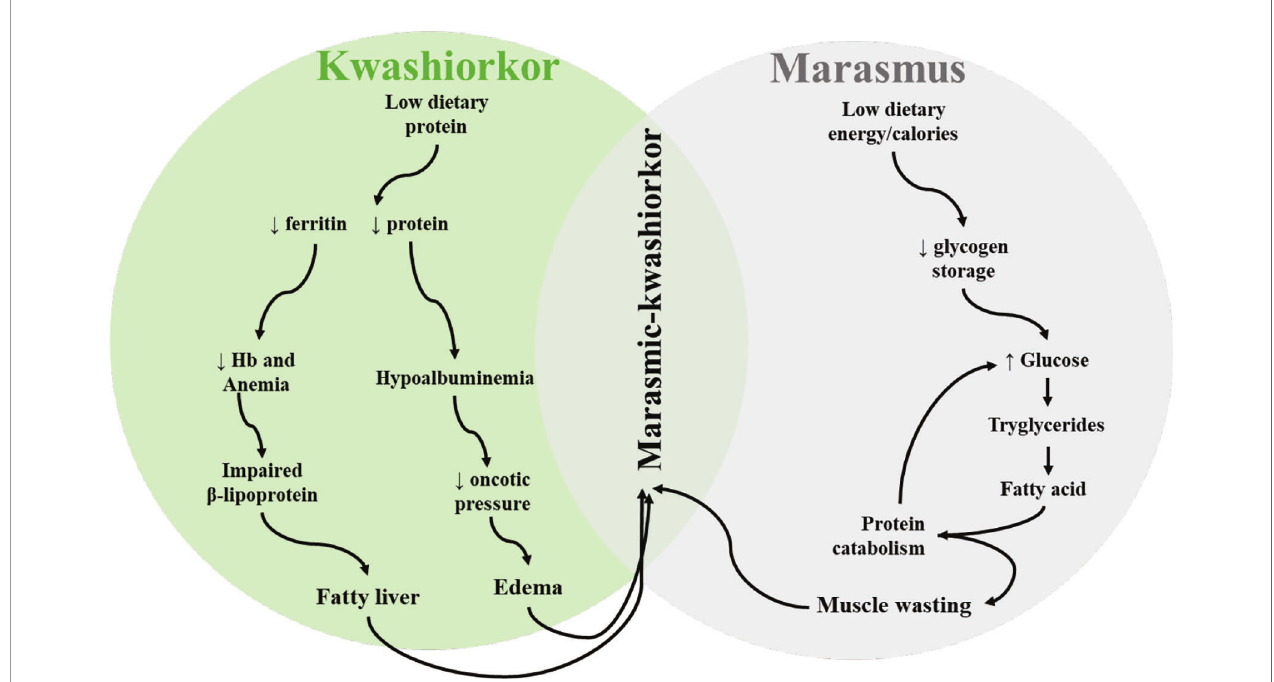
FIGURE 2 | Schematic depiction of pathobiological features and interactions observed in different types of malnutrition (kwashiorkor and marasmus) in